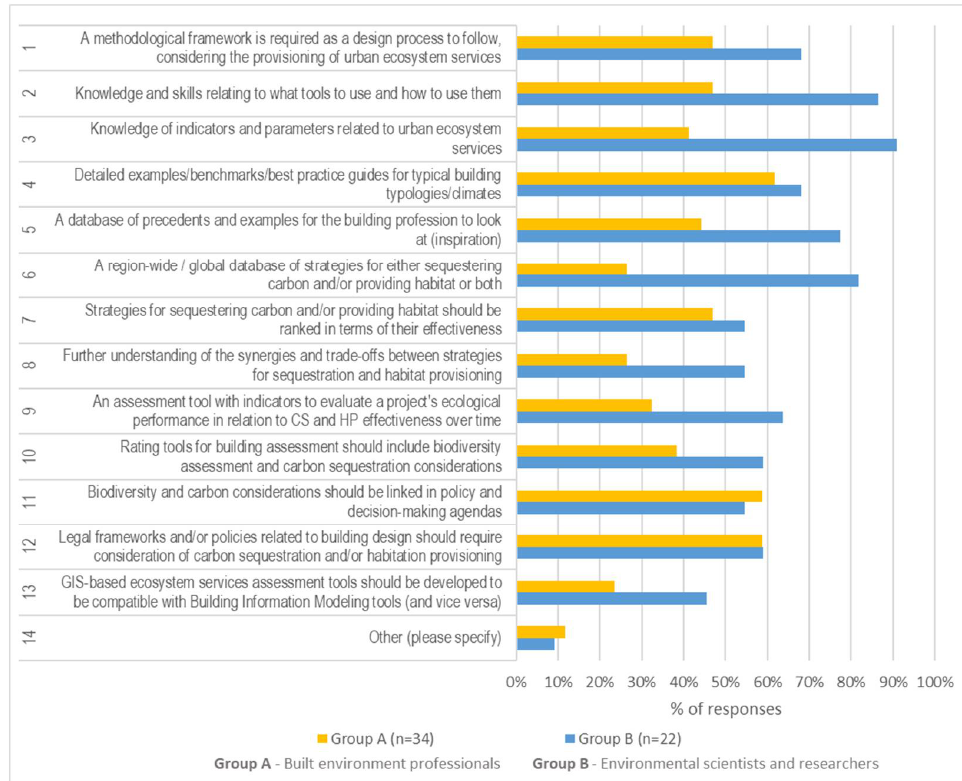
Figure 19. Solutions or requirements for successfully implementing habitat provisioning and car- bon sequestration strategies. sequestration